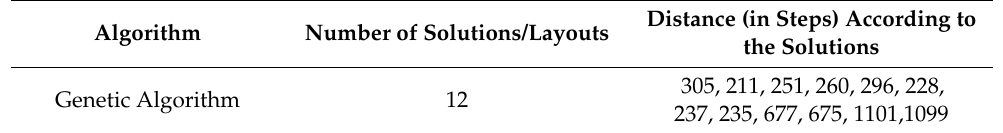
Table 2. Distances travelled in the layouts obtained by genetic algorithm.